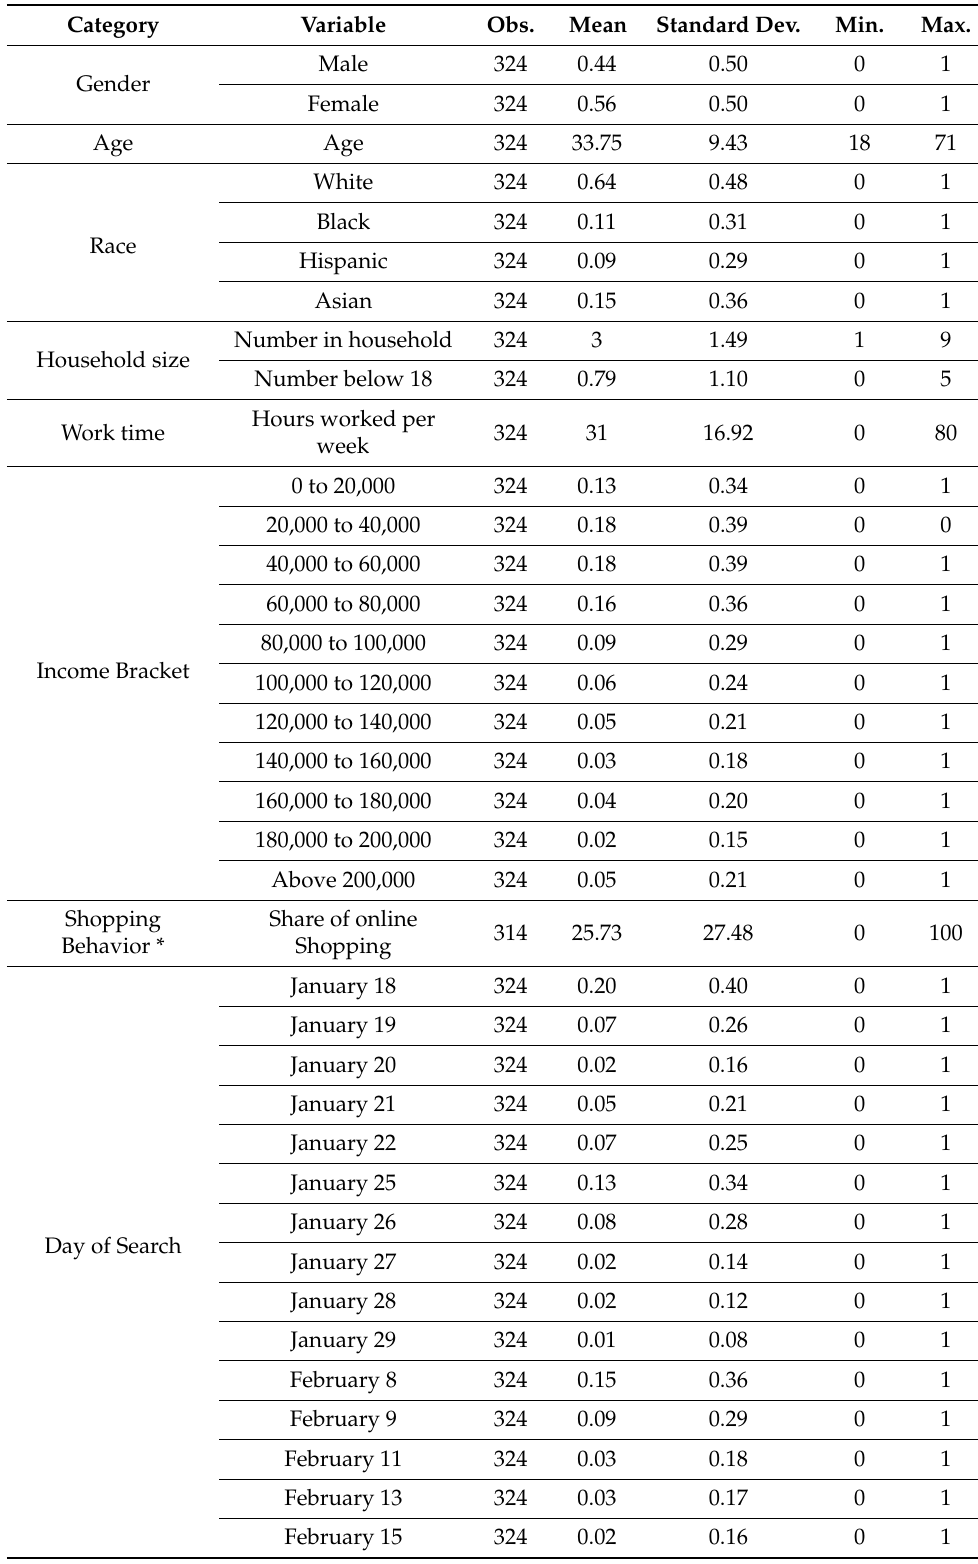
Table 1. Survey respondents’ characteristic summary statistics. For categorical variables, the mean represents the percentage of observations belonging to the indicated